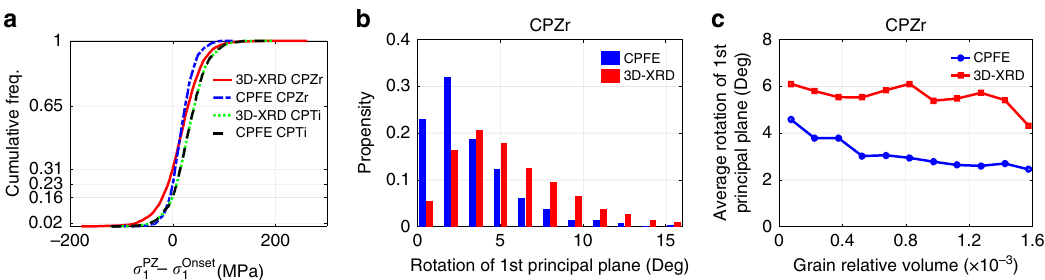
Fig. 9 Investigation of the 1st principal stresses and their associated 1st principal planes. a Cumulative frequency of 1st principal stress drop for CPTi and CPZr. PZ refers to plastic zone, where maximum strains of 1.2% and 0.94% were applied to CPZr and CPTi samples, respectively. b Rotation of 1st principal planes of each grain from onset to maximum load in CPZr. c Average rotation of 1st principal planes as a function of grain-measured